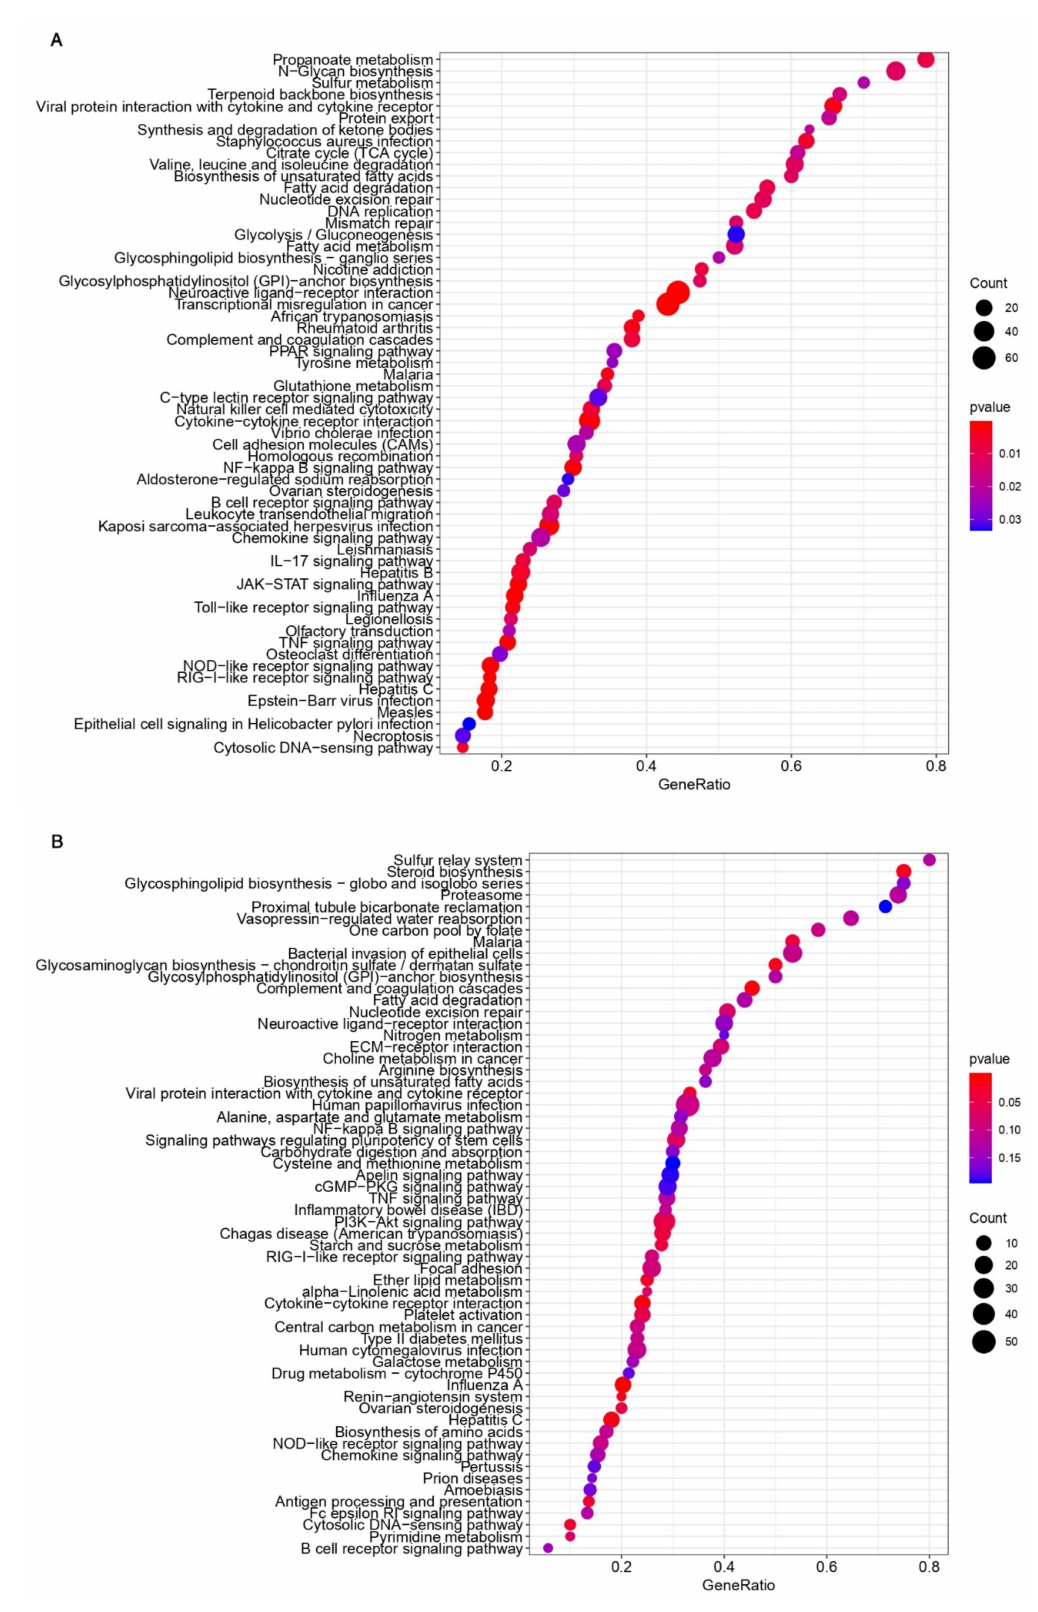
Figure 5. Kyoto Encyclopedia of Genes and Genomes (KEGG) gene set enrichment analysis of DEGs in human ( A ) and pig ( B ) cells at 24 hpi. Enriched signaling pathways with p < 0.05 were considered to be statistically